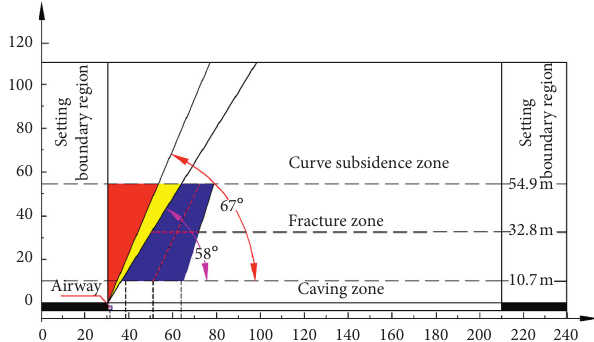
Figure 10: Drainage parameters versus height of the GDR in #1207 working face.